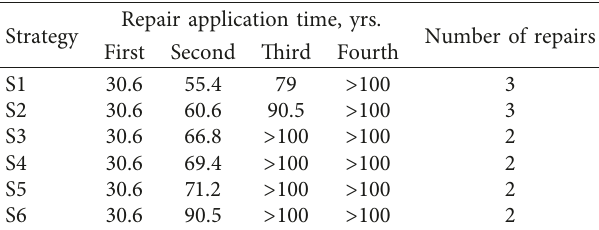
Table 3: Number of repairs and repair application time for six strategies by deterministic assessment. Repair application time, Strategy